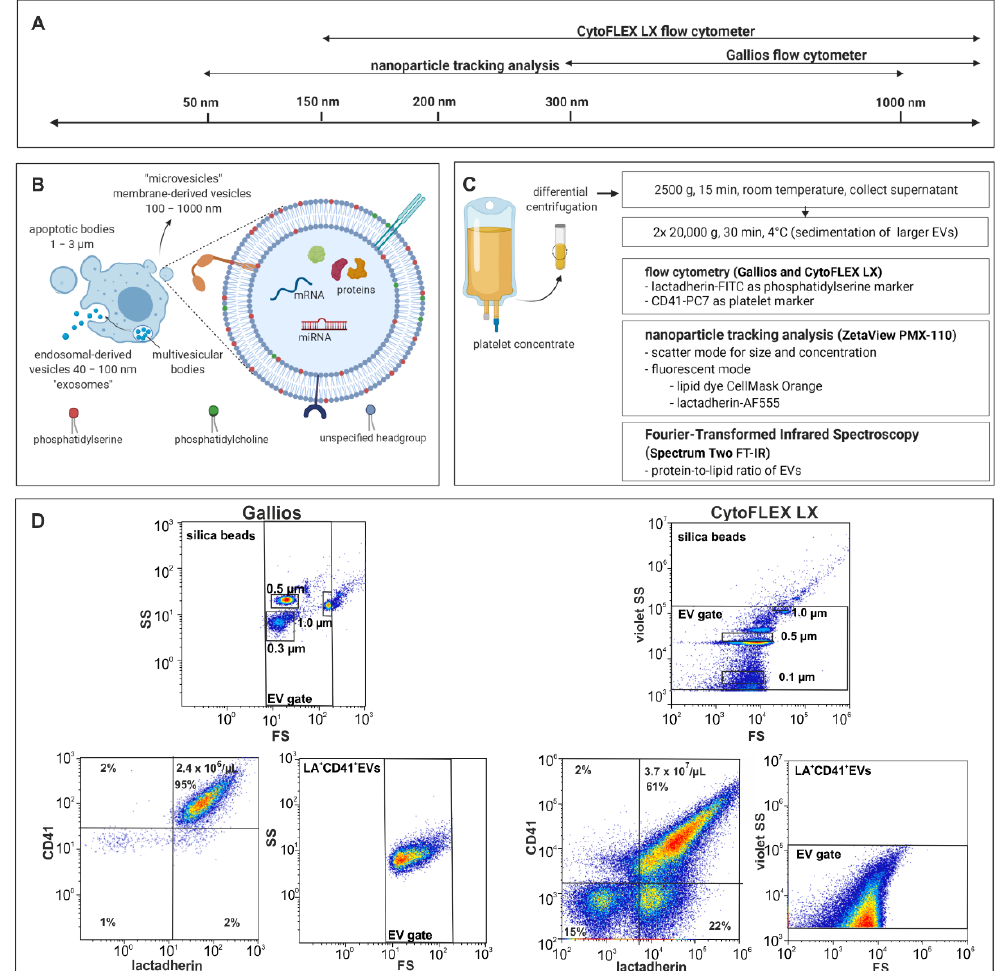
Figure 1. Characterization of EVs by flow cytometry and NTA. ( A , B ) Size-dependent resolution limits of the devices and approximate size range of EV subpopulations (exosomes, microvesicles, and apoptotic bodies). ( C ) Enrichment and characterization of platelet-derived EVs. Platelet-derived EVs were enriched from medical grade platelet concentrates by differential centrifugation as described in the Methods section and characterized by flow cytometry using lactadherin as a marker of phosphatidylserine expressing EVs and CD41 as platelet marker. Further analysis was performed by NTA in scatter mode and in fluorescence mode after staining of EVs with CellMask™ Orange (CMO) and lactadherin-Alexa Fluor™ 555 (LA-AF555). The protein-to-lipid ratio was assessed by Fourier-transformed infrared spectroscopy. ( D ) Representative images of EV gating and scatter plots for the CytoFLEX LX vs. Gallios flow cytometers. Phosphatidylserine exposing platelet-derived EVs were identified as lactadherin + and CD41 + events in the EV gate. Figure 1A–C was created with BioRender.com (accessed date: 05.04.2021).